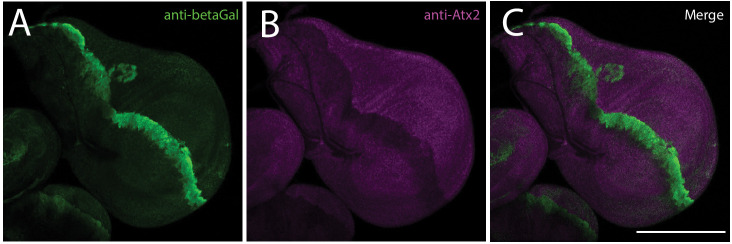
Atx2 RNAi knockdown reduces Atx2 expressions.Ptc-Gal4 was used to drive Atx2 RNAi in Drosophila wing disc and immunostained with anti-beta-Gal (A) and anti-Atx2 (B) antibodies. Atx2 levels are reduced in the Gal4-expressing cells (C).
Figure 3—figure supplement 1—source data 1.Data related to RNAseq mapping percentage from Gal4 and Atx2 RNAi brains.